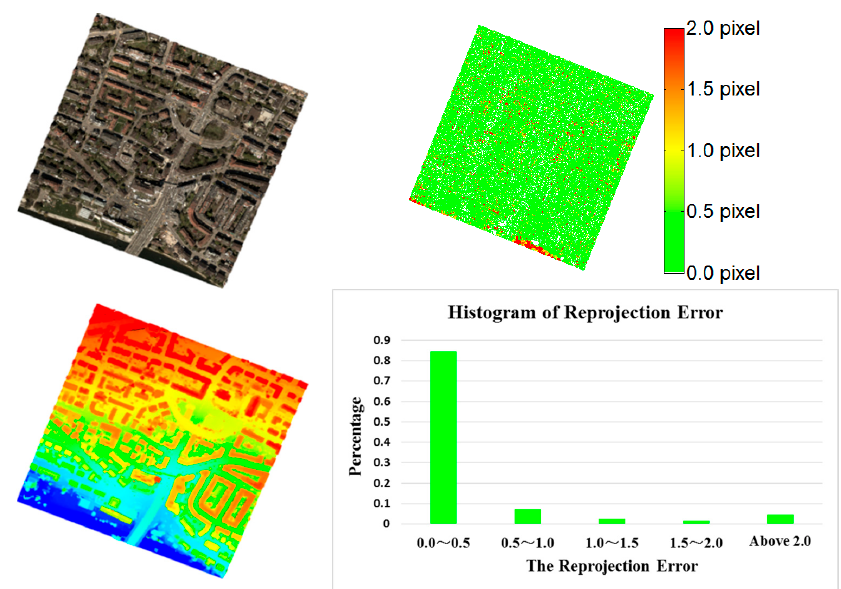
Figure 9. The fused result of multi-view point clouds are presented (Top left: the colorized point cloud, Bottom left: the height map of point cloud, Top right: the accuracy map of average projection error, Bottom right: the histogram of reprojection error).